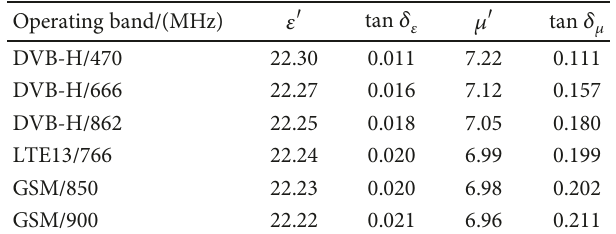
Figure 1: Simulated relative permittivity and permeability of the experimental magneto dielectric substrate (ECCOSORB MF-124) relative to frequency (400 – 1000 MHz). Table 1: The simulated relative permittivity and permeability of ECCOSORB Mf-124 for various operating frequencies (470 –